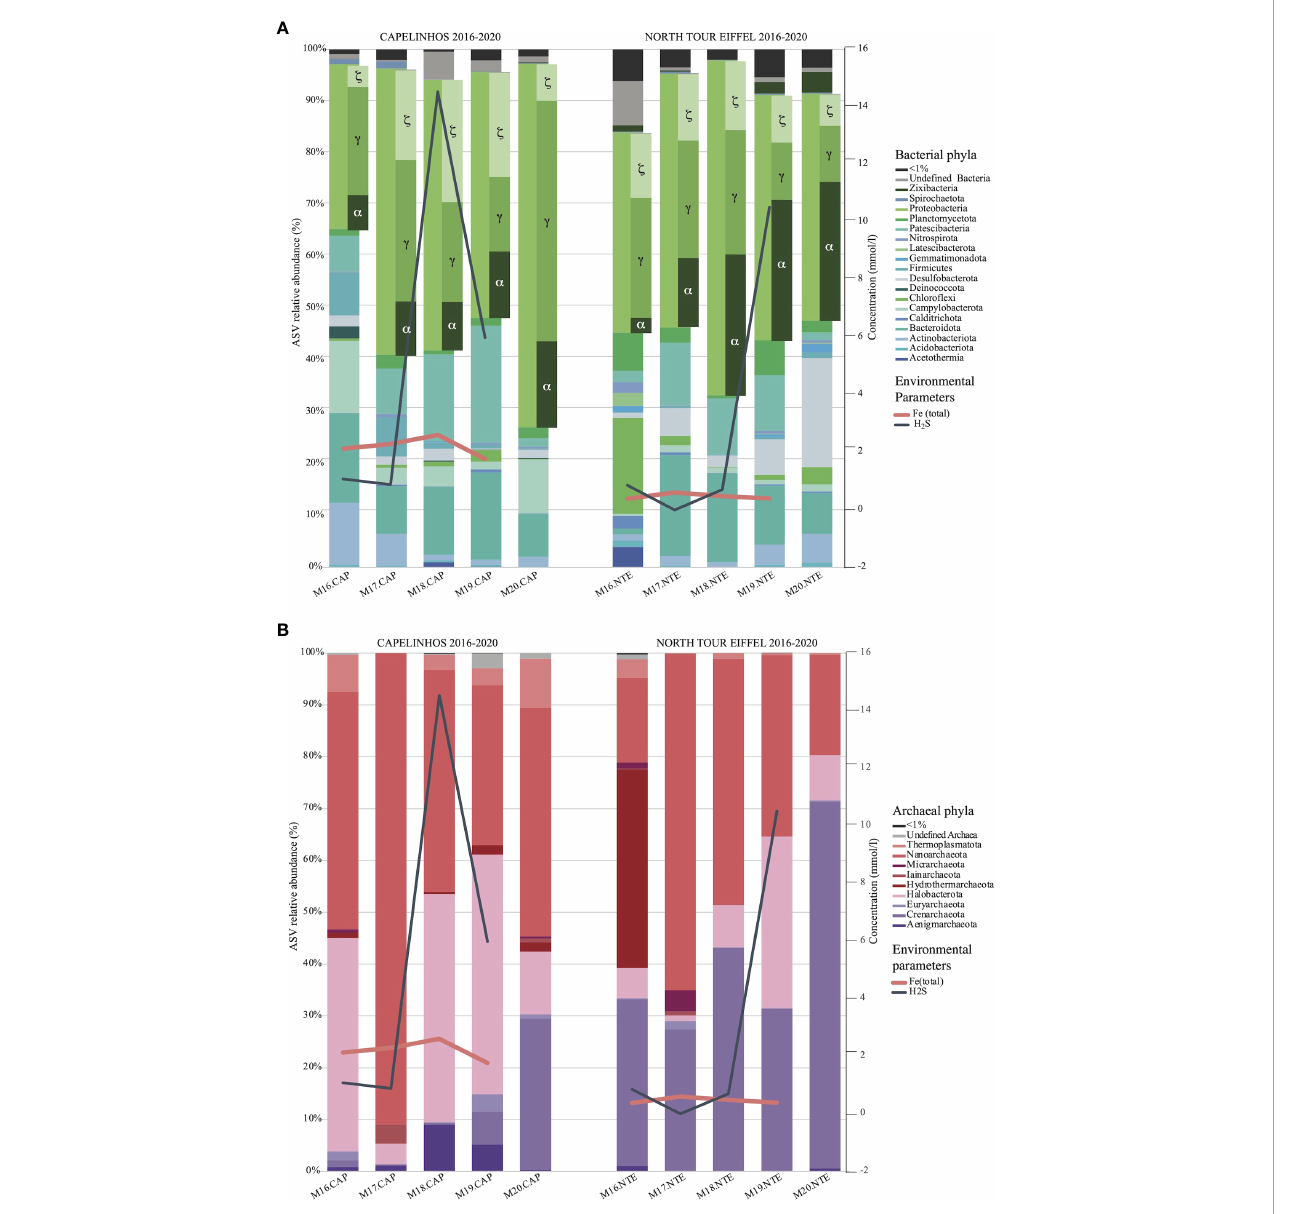
FIGURE 6 Bar plot depicting the abundance (%) of bacterial (A) and archaeal (B) phyla for each year (2016-2020) and for each site (Capelinhos in the left and North Tour Eiffel in the right). Only the phyla having an incidence higher than 1% are presented in the plot. The representation of the Proteobacteria phylum also includes the abundance of the different classes that conform it. Environmental parameters are represented as line plots superposed with the bar plots, depicting the concentration of dFe (pink) and dH 2 S (grey) in each year and each site. Environmental parameters are not presented for 2020 as no hydrothermal fl uid samples could be collected on that year due to the Covid-19